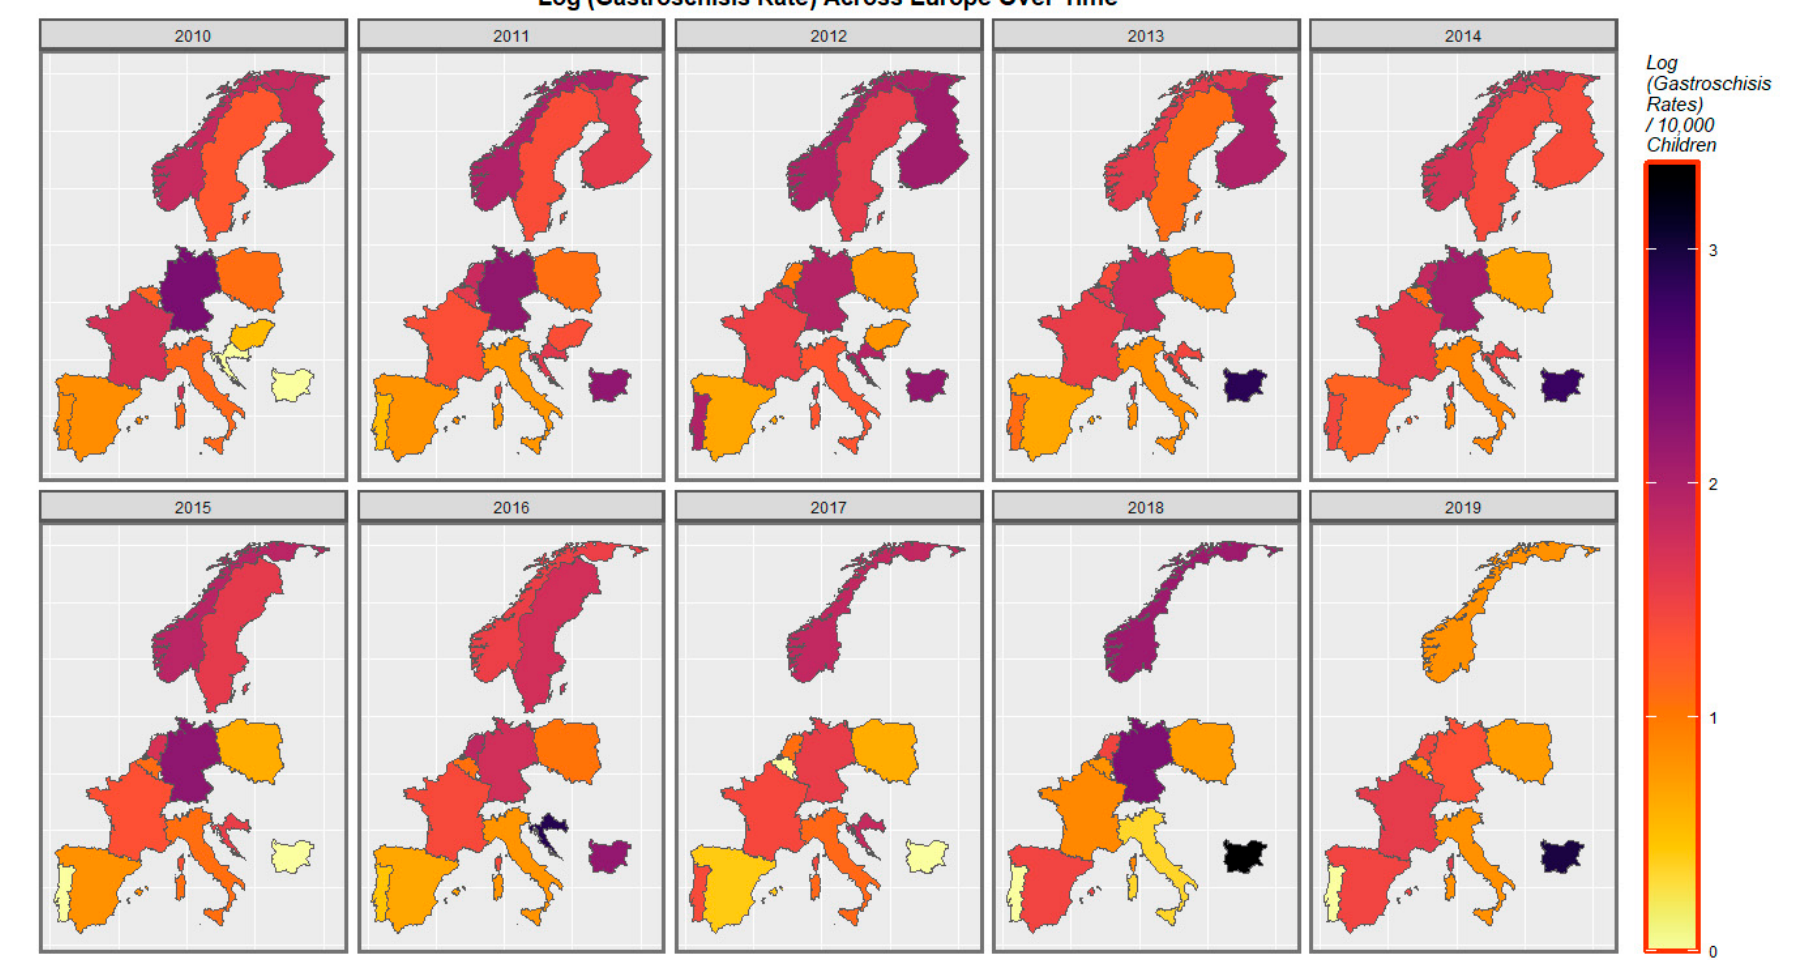
Figure 4. Sequential map-graph of gastroschisis across selected European nations for each year of 2010–2019.